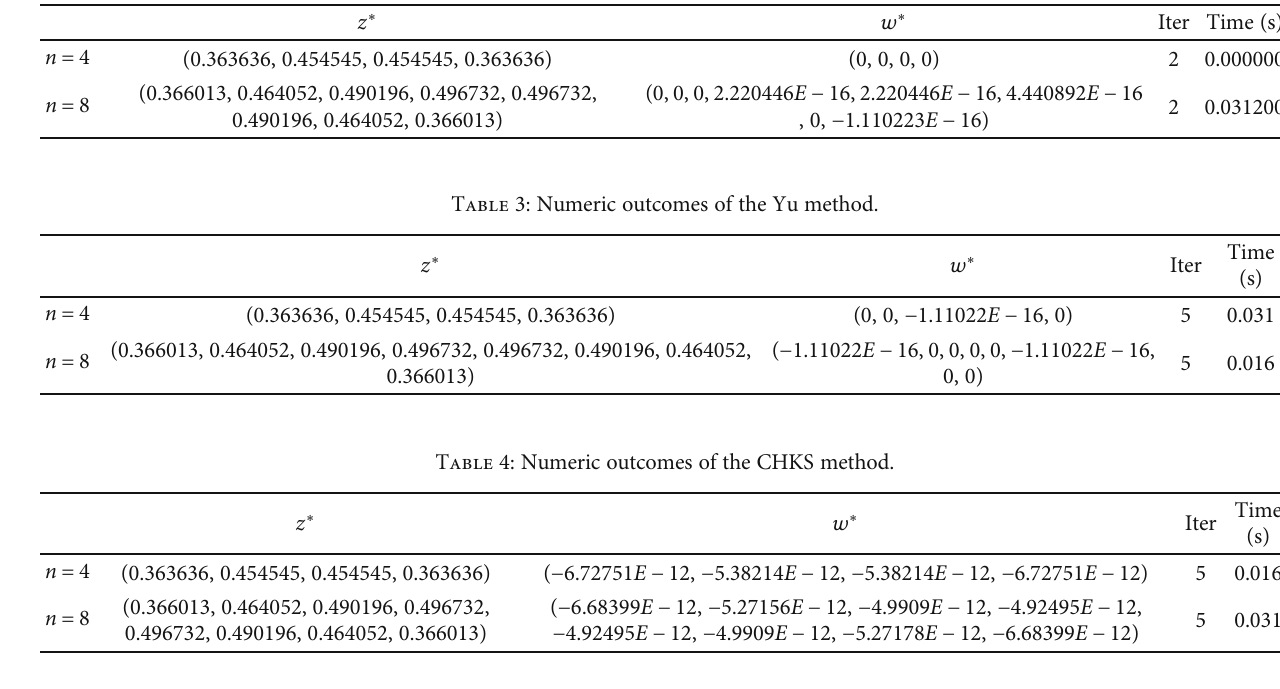
Table 2: Numeric outcomes of the El foutayeni method.